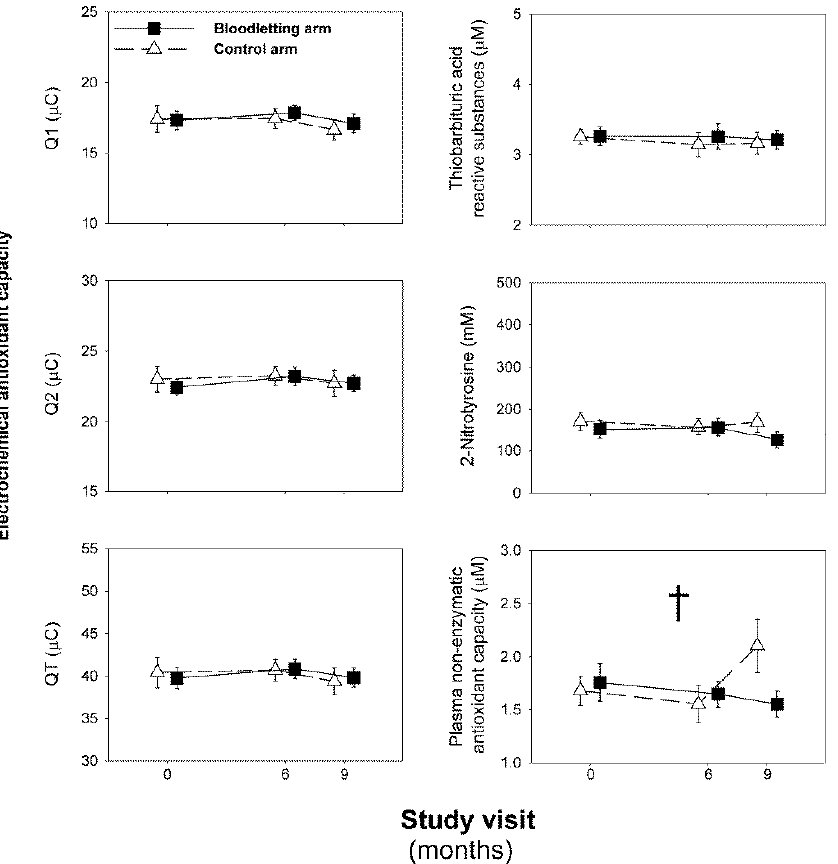
Figure 4. Changes in oxidative stress biomarkers throughout the experimental phase of the trial. We show data as means (SEM) of the patients remaining at each visit of the trial, even though we conducted intention-to-treat statistical analyses. Data were submitted to a repeated-measures general linear model. † Statistically signi fi cant interaction between the visits and the arm of the study.